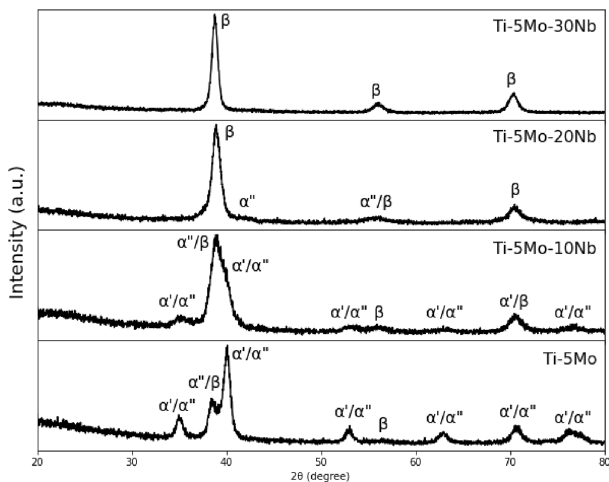
Figure 4. X-ray diffractograms of as-cast Ti-5Mo-Nb system